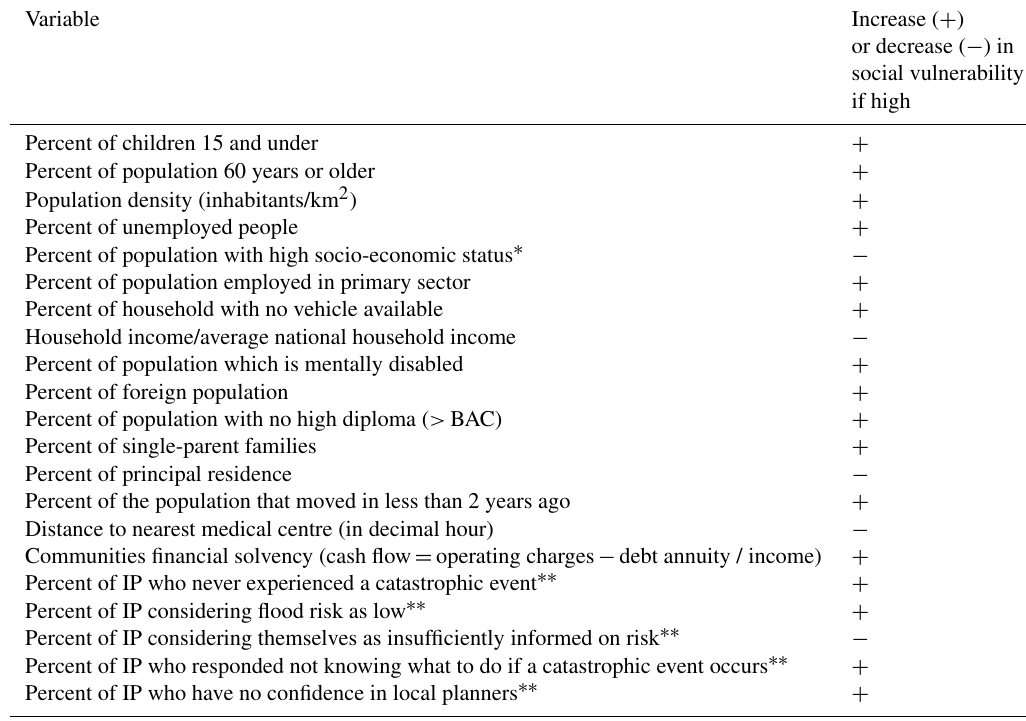
Table 4. First set of criteria selected for the calculation of SCI and their impacts on social vulnerability. Variable Increase ( + )